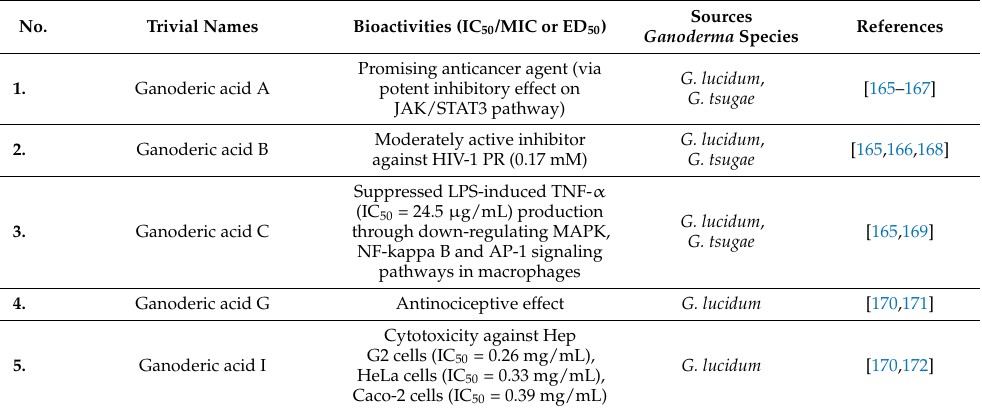
Table 1. 8,9-double-bond triterpenoids and bioactivities from Ganoderma .